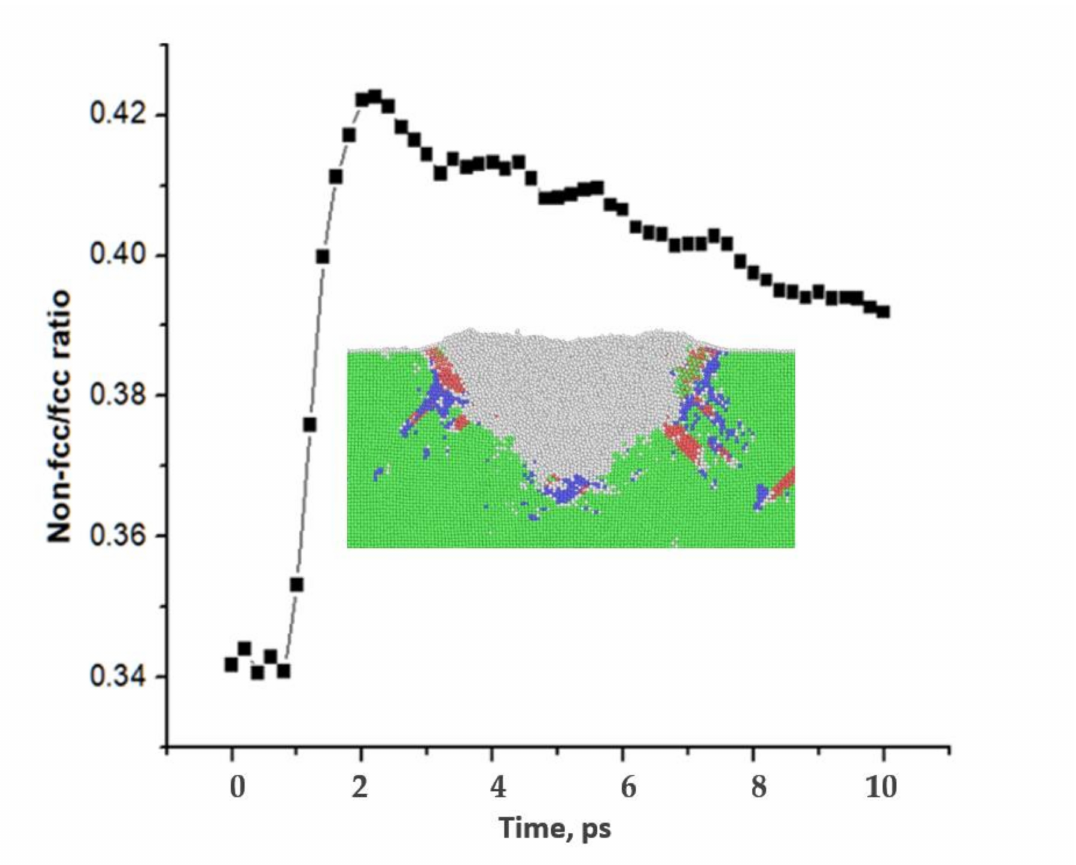
Figure 6. Structural transformation (defect nucleation) at the depth of indentation showing non-fcc / fcc structures ratio with time. Inset: cross-section of Pd thin film (green: fcc structure; grey, blue and red: non-fcc